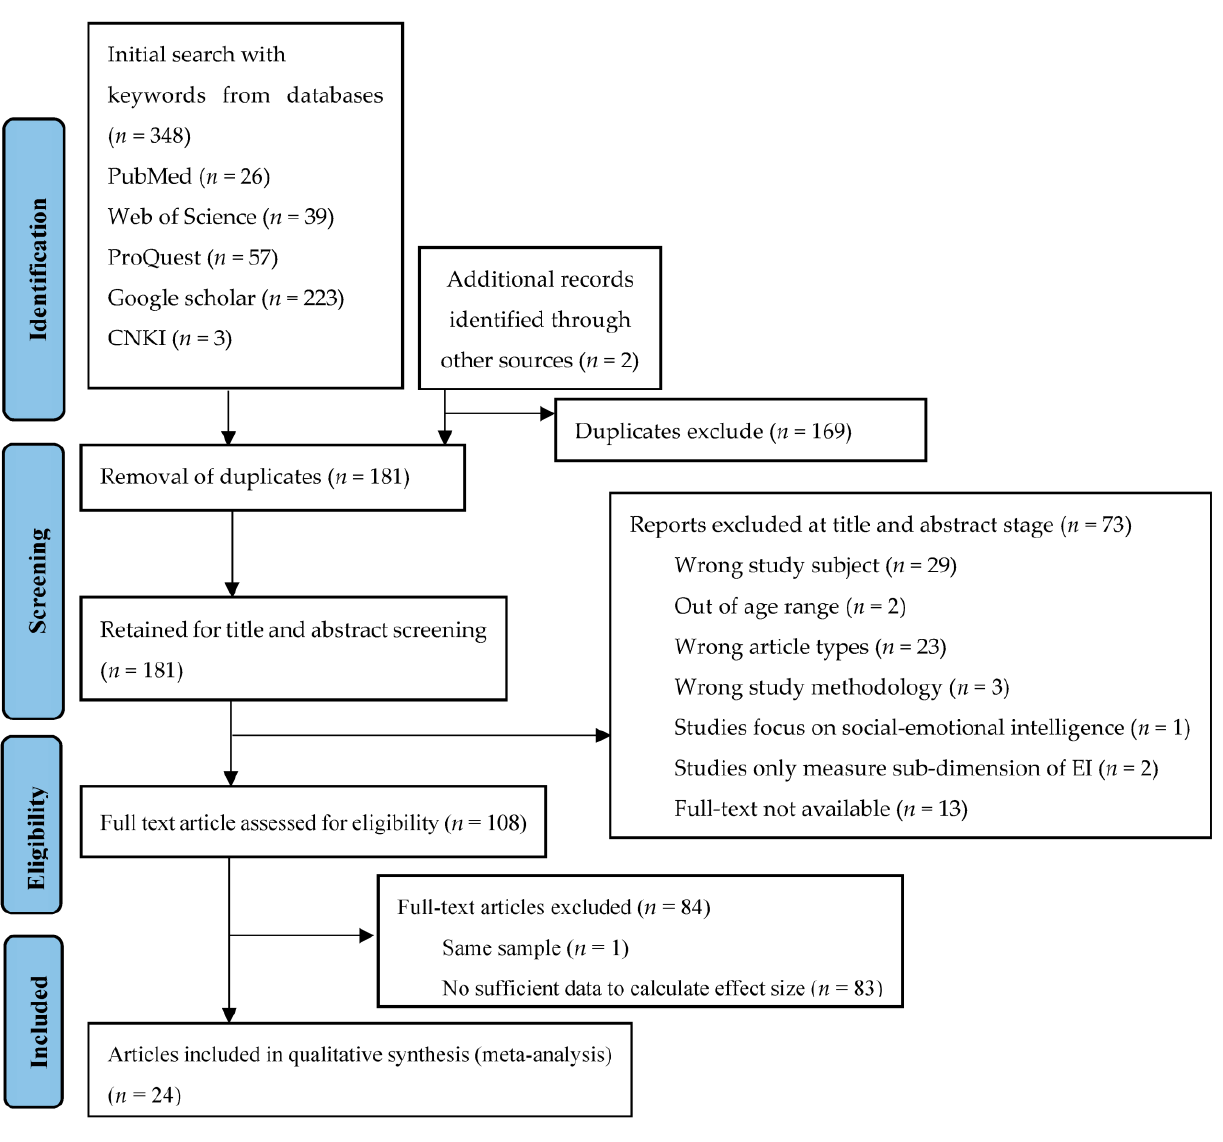
Figure 1. PRISMA flow chart of study selection.